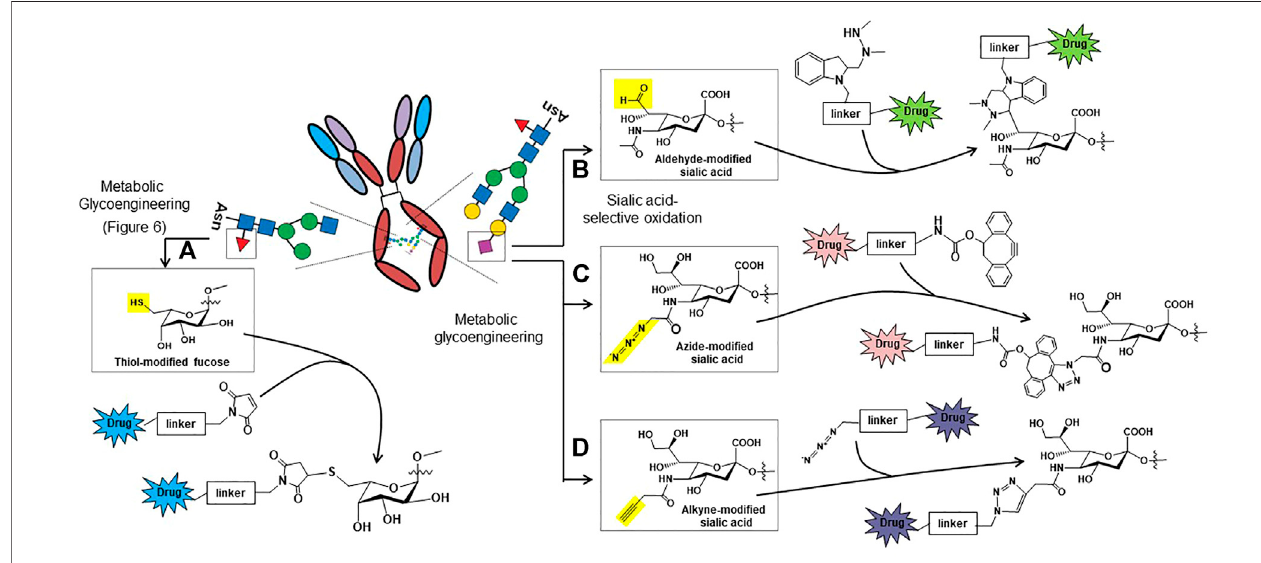
FIGURE 5 | Glycosylation-based antibody-drug conjugate (ADC) ligation strategies based on chemically-modi fi ed fucose (A) or sialic acid (B, C, and D). (A) Thiols can be installed into non-natural fucose using metabolic glycoengineering and used as “ chemical handles ” to ligate drug molecules to the Fc domain glycans of antibodiesusingthiol-reactivemaleimides(Okeleyetal.,2013). (B) AldehydescanbeselectivelyintroducedintosialicacidsbyoxidizingtheC8-OHgroups;thealdehyde then canbeconjugatedtodrugsusingthehydrazino- iso -Pictet-Spengler(HIPS) reaction (Drakeet al.,2014). (C) Metabolic glycoengineeringcanbeused toinstall azido-sialic acids into glycans (Saxon & Bertozzi 2000), which can then be used to conjugate drugs to the antibody using dibenzocyclooctyne (DIBO) conjugation reactions (Li et al., 2014). (D) Alkyne groups can also be introduced into sialic acids through metabolic glycoengineering, which can then be conjugated using conventional copper catalyzed click chemistry (Du et al., 2009; Hong et al., 2010).